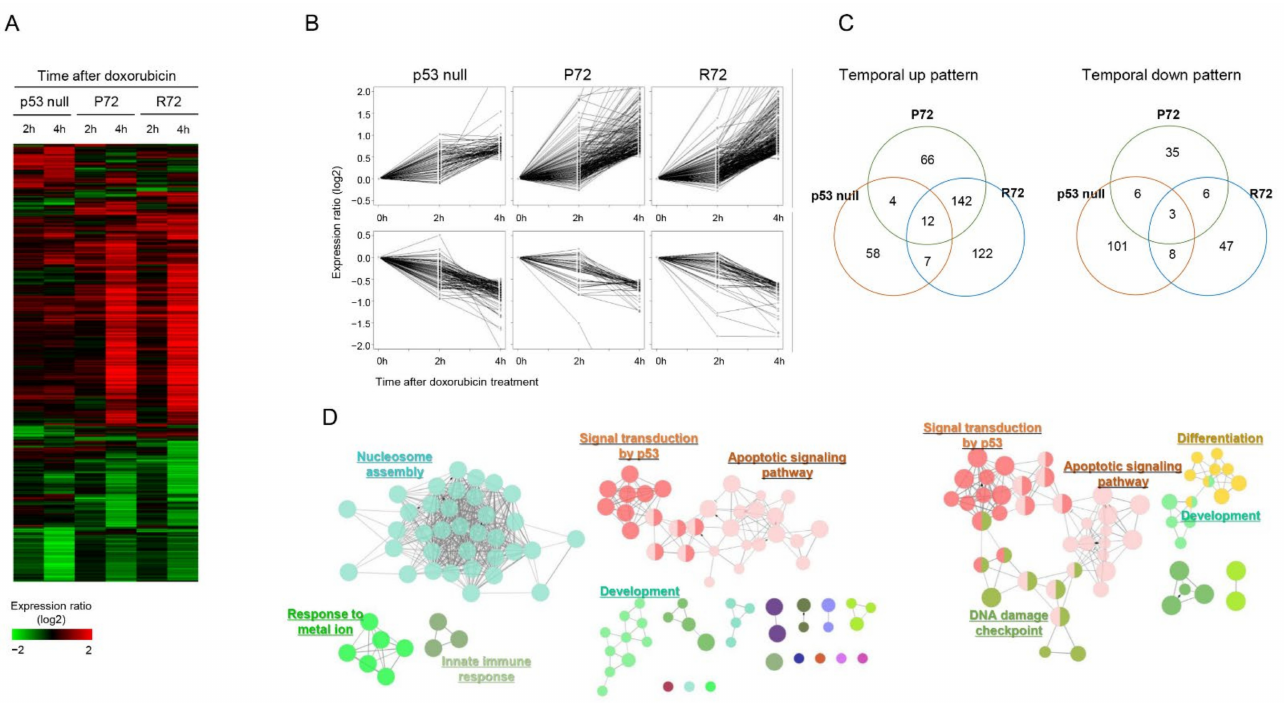
Figure 2. Effect of p53 status on doxorubicin-induced gene expression: ( A ) 600 genes showing an expression change of at least 0.1 standard deviation in samples were clustered according to the expression level. Red and green color represents high and low expression level, respectively, as shown in the scale bar. ( B ) Genes showing temporal pattern of expression were isolated in P72, R72, and p53 null cells. ( C ) Distribution of temporally regulated genes were compared among P72, R72, and p53 null cells. ( D ) Association of temporally regulated genes from P72, R72, and p53 null cells with the GO term was measured using the ClueGO program to make a GO-term network. Each node represents a GO term, and the node size is proportional to the number of genes associated with the GO term. Closely related GO terms are marked with the same color. Representative GO terms are